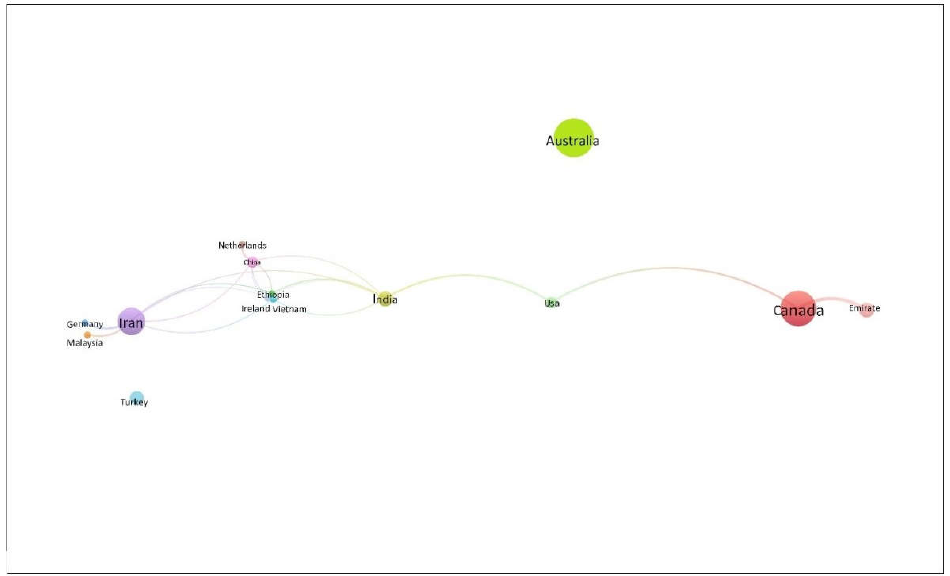
Figure 5. Network visualization map of country co-authorships on AI-based RFFA research field.